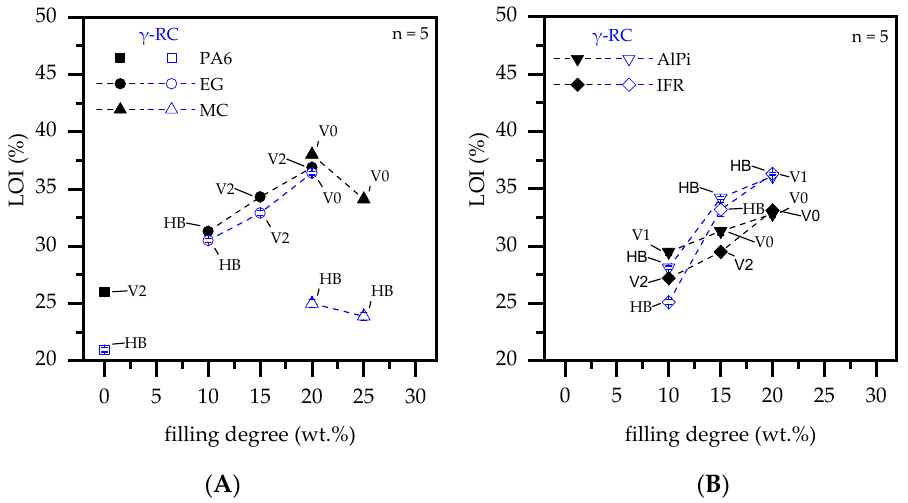
Figure 16. LOI and UL ‐ 94 V testing results for 1 mm ‐ thick samples. ( A ) PA6, PA6/EG and PA6/MC formulations. ( B ) PA6/AlPi and PA6/IFR.